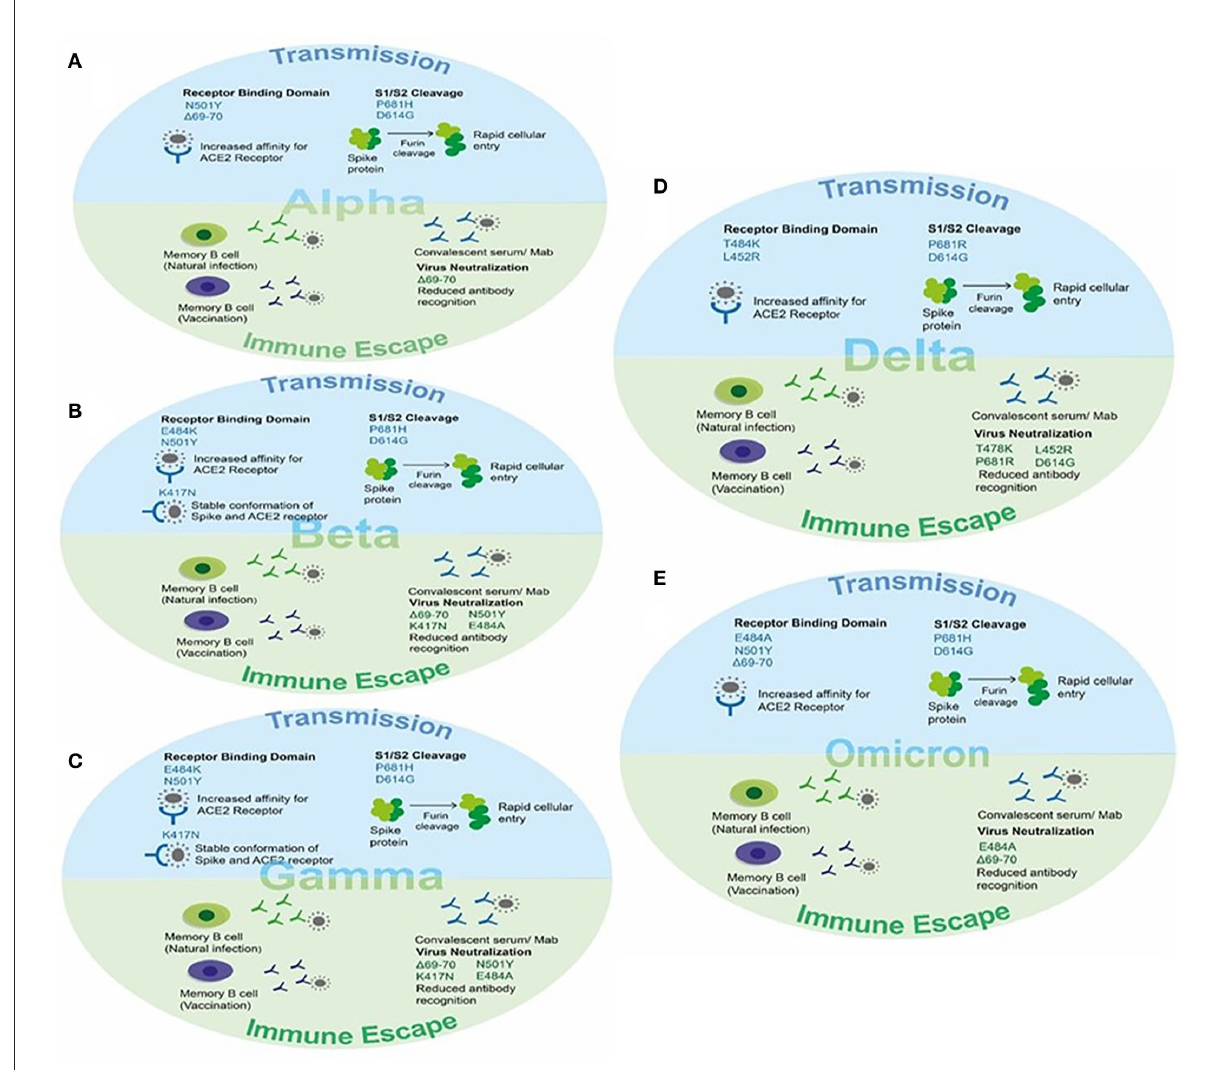
FIGURE5 The effect of key mutations of SARS-CoV-2 variants on virus transmission and immune susceptibility. (A) Key mutations on Alpha VOC involved in transmission and immune escape. (B) Key mutations on Beta VOC involved in transmission and immune escape. (C) Key mutations on Gamma VOC involved in transmission and immune escape. (D) Key mutations on Delta VOC involved in transmission and immune escape. (E) Key mutations on Omicron VOC involved in transmission and immune